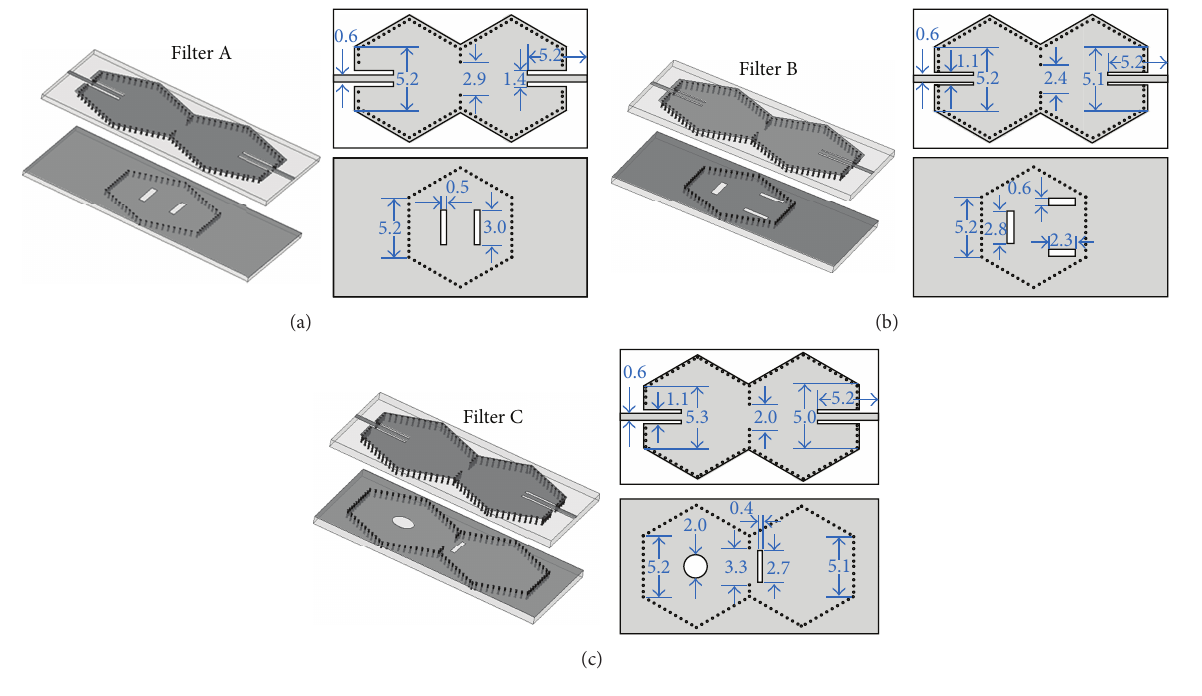
Figure 5: Final dimensions of Filters A, B and C. (unit mm).